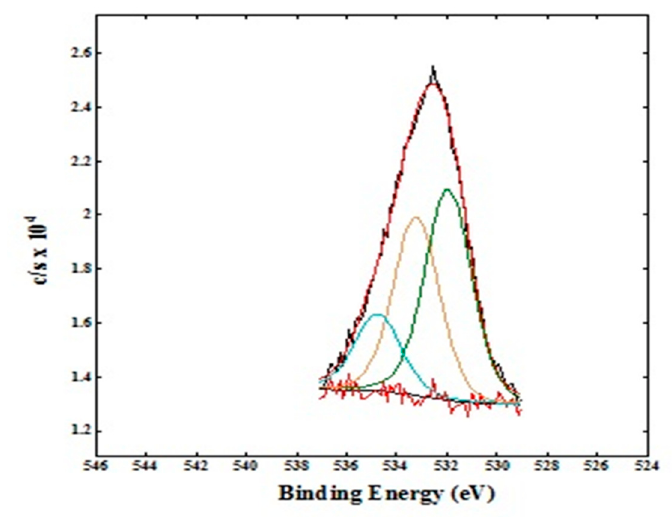
Figure 5. XPS spectrum for the O1s region for the compound Bi 2 O 2 CO 3 :Al. Table 4. Atomic concentrations and assignments for the O1 s region for the compound Bi 2 O 2 CO 3 :Al. Bond Energy for O1 s (eV) % by Type of O1 s Assignation 531.8 38.66 AlO(OH) 533.2 41.22 CO 32– 534.8 20.12 H 2 O